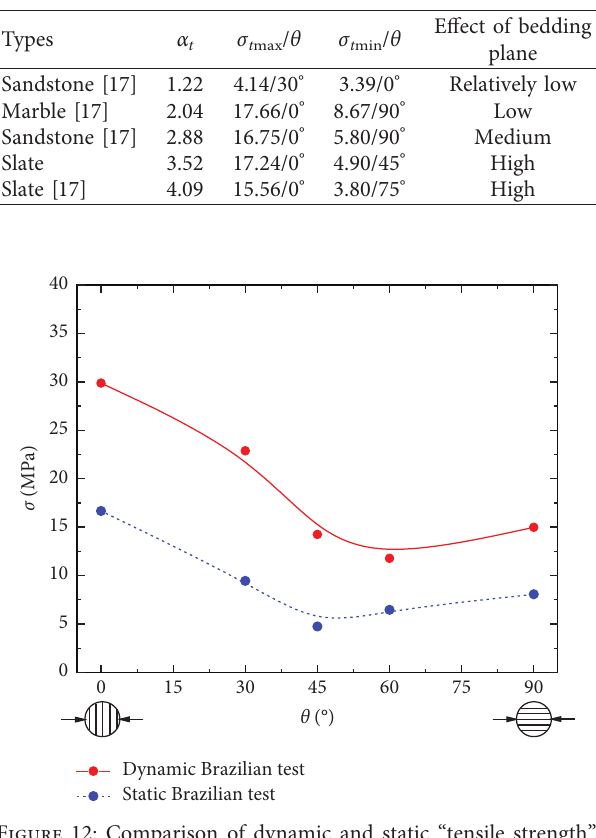
Figure 12: Comparison of dynamic and static “tensile strength” under different dip angles.